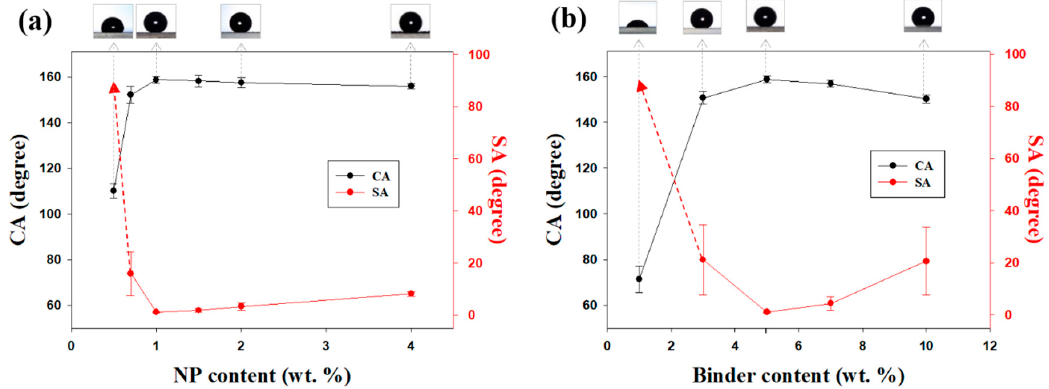
Figure 3. CAs and SAs of spray-coated samples with ( a ) NP contents of 0.5, 0.7, 1.0, 1.5, 2.0, and 4.0 wt. % with 5 wt. % of binder, and ( b ) binder contents of 1, 3, 5, 7, and 10 wt. % with 1 wt. % of NP content.